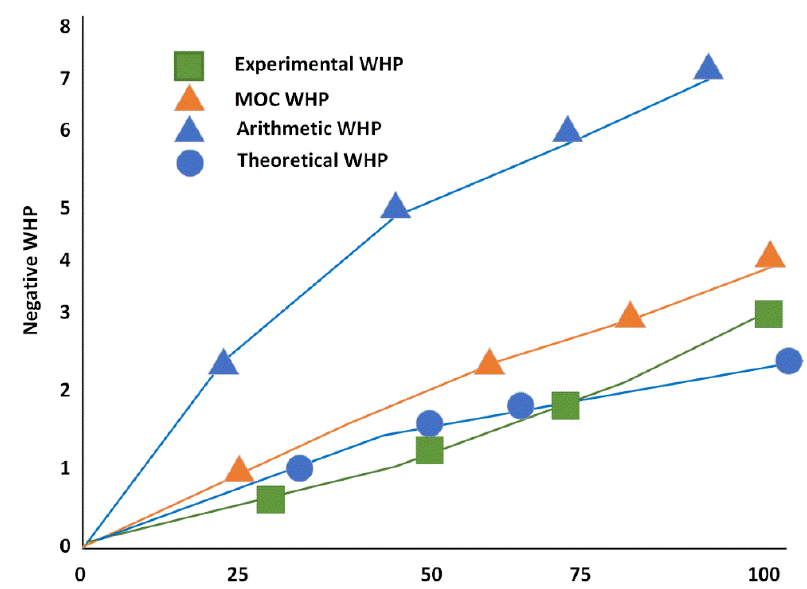
Figure 14. Variation of water hammering pressure along with the percentage of valve opening.